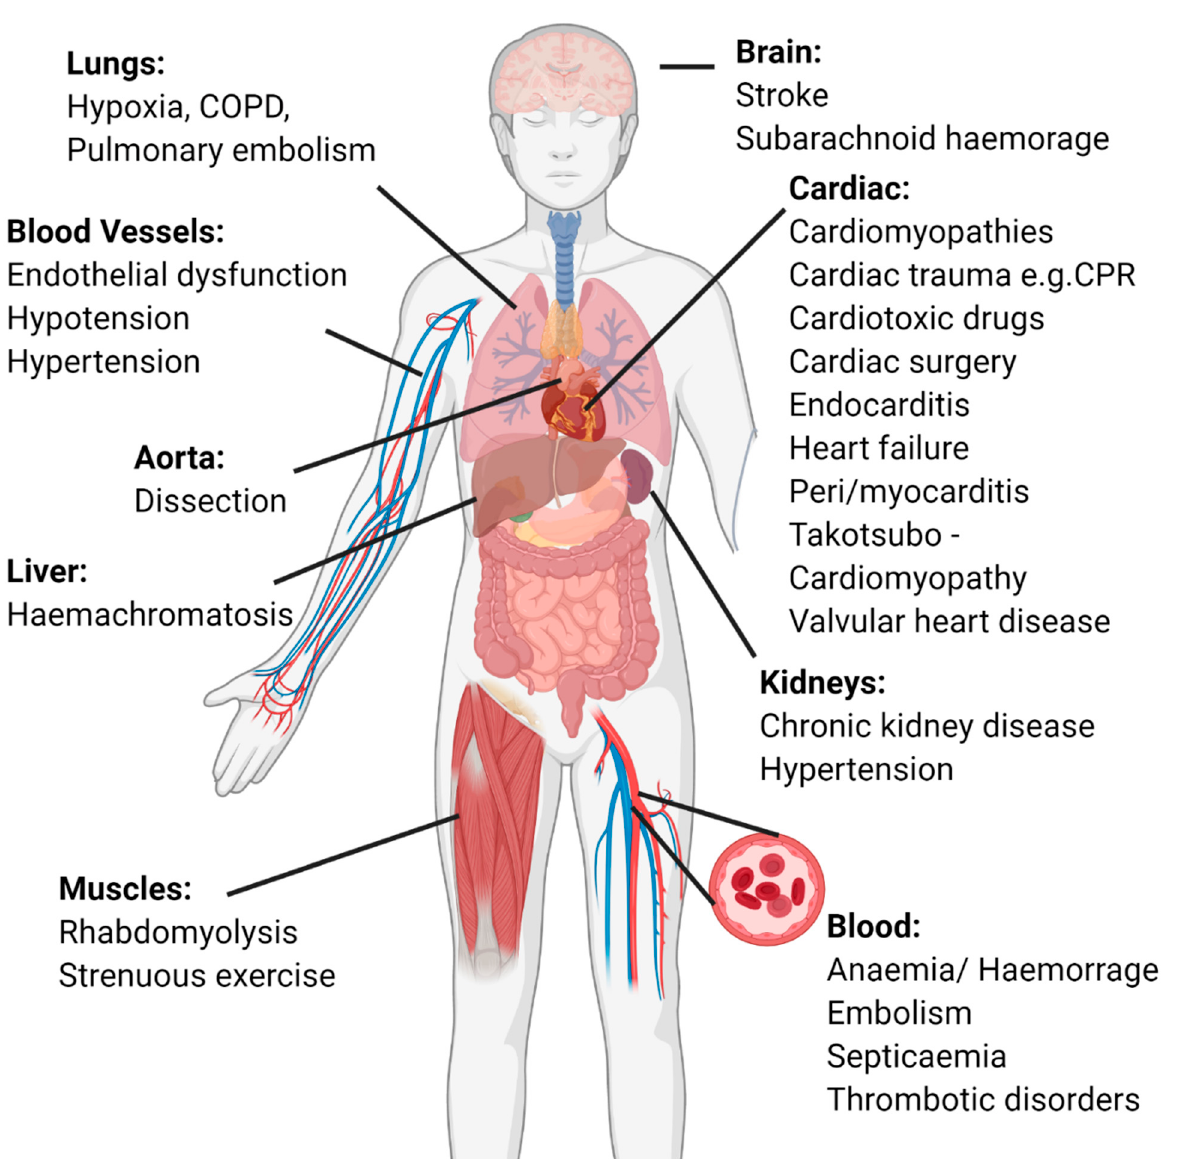
Figure 3. Systems-based approach to identifying causes of myocardial injury, listing common aetiologies in each system.